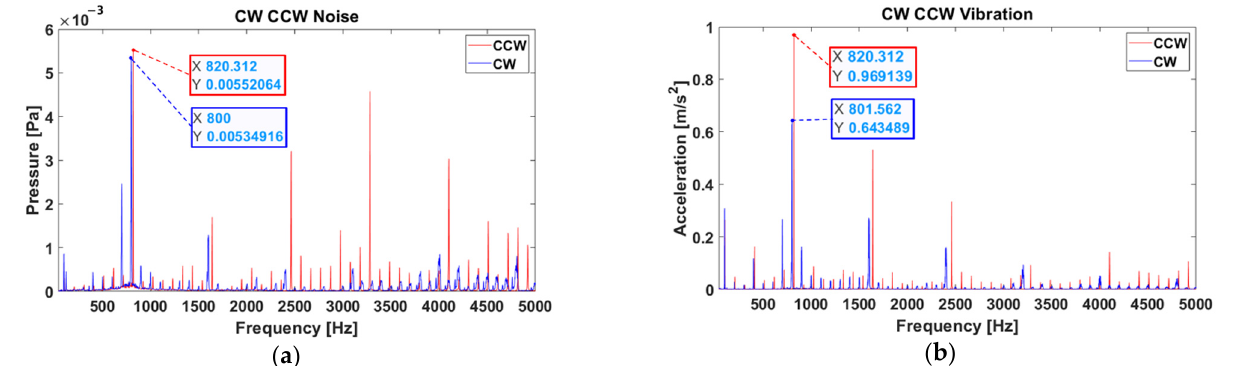
Figure 6. Comparison of CW (clockwise) and CCW (counterclockwise) of the sample motor. The figure shows that even if the same voltage is applied, the noise and vibration of CW and CCW differ in magnitude and frequency. The direction of rotation is shown in ( a ), and in the graph, red is CCW and blue is CW: ( a ) Results of FFT of CCW and CW noise components; ( b ) results of FFT of CCW and CW vibration components.